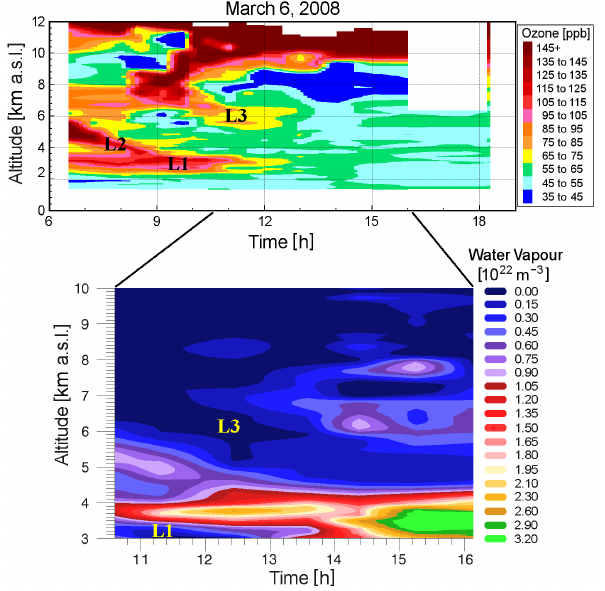
Figure 1. Ozone and water-vapour sounding series on Fig. 1. Ozone and water-vapour sounding series on March 6, 2008, showing three high-ozone (low- 6 March 2008, showing three high-ozone (low-humidity) lay- humidity) layers (L1-L3) caused by a stratospheric air intrusion system; the time is given with ers (L1–L3) caused by a stratospheric air intrusion system; the respect to 0:00 CET (Central European Time, = UTC + 1 h). The numbers denoting the colour of a time is given with respect to 00:00CET (Central European Time, given H 2 O density range correspond to the respective lower boundary. = UTC + 1h). The numbers denoting the colour of a given H density range correspond to the respective lower boundary.